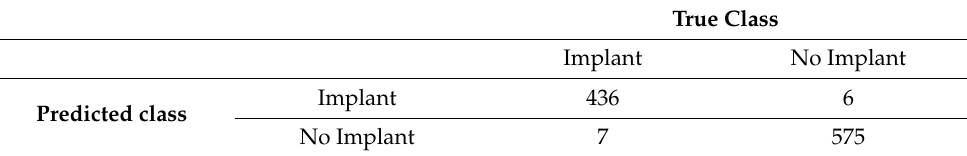
Table 3. Confusion table of the logistic regression.